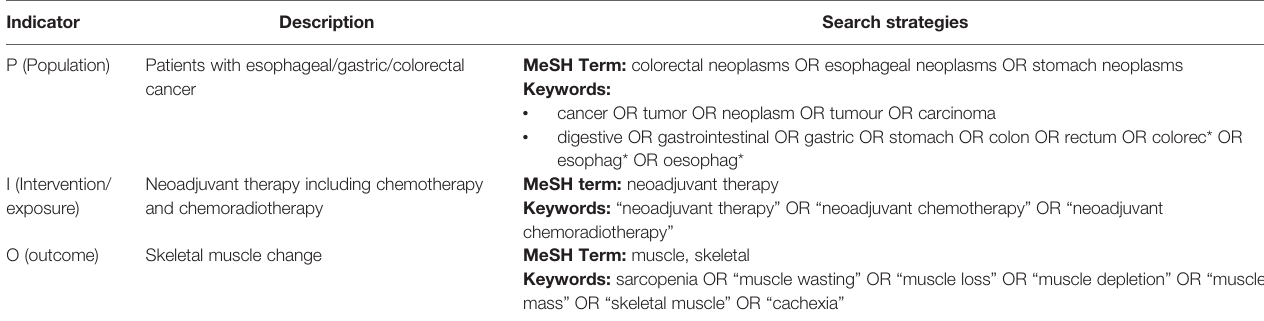
TABLE 1 | Search strategies according to PICO